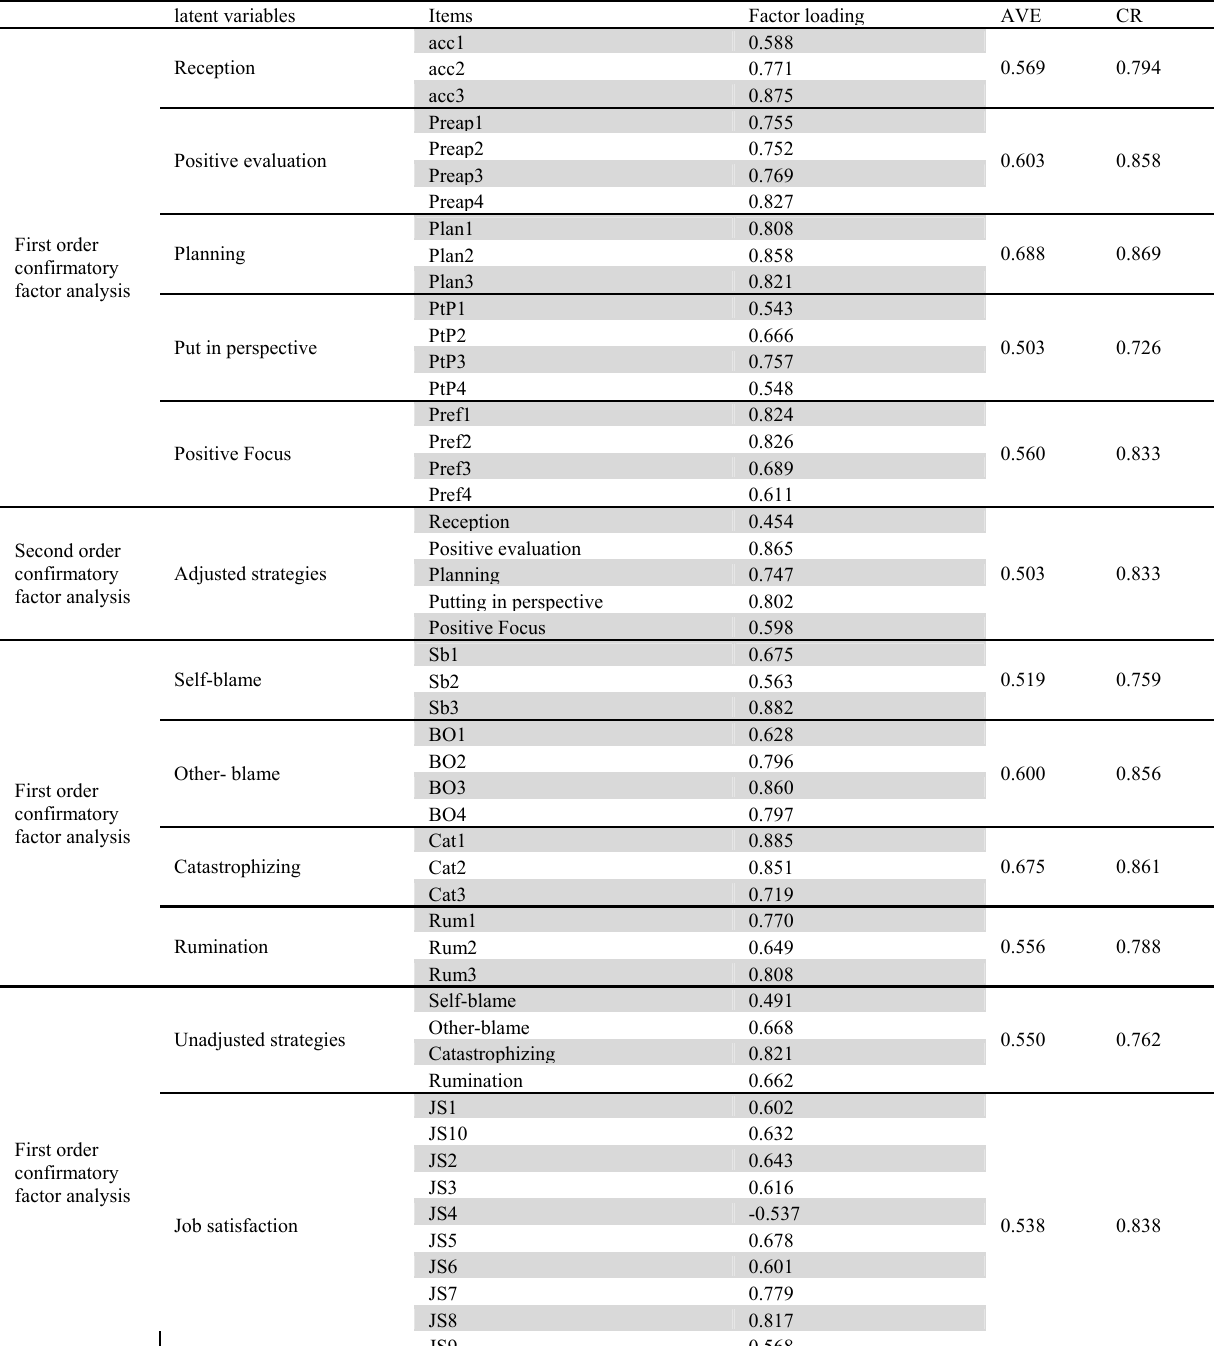
Validity, Composite reliability and factor